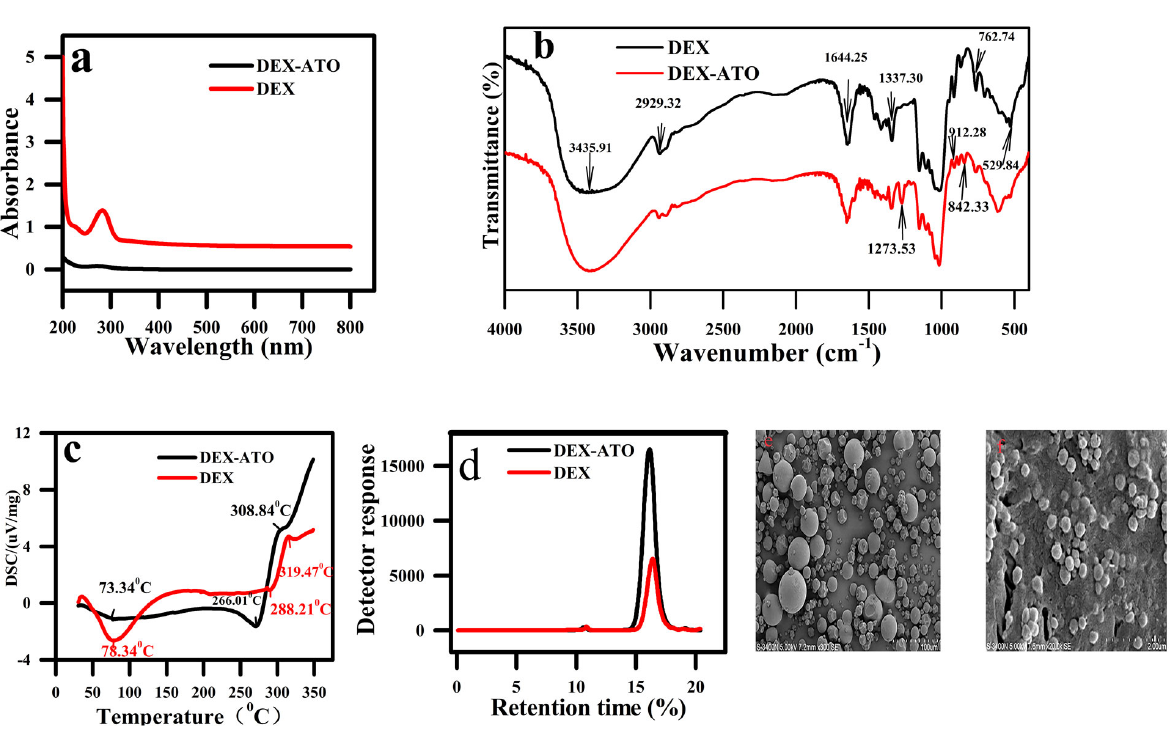
Figure 2. Structural characterization of DEX and DEX-ATO. (a) UV; (b)FTIR; (C) DSC; (d) HPGPC; (e) SEM of DEX; (f) SEM of